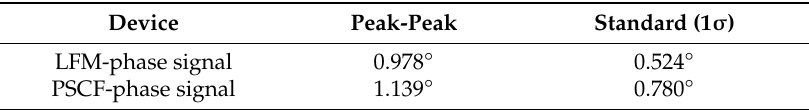
Table 2. The comparison results of two phase synchronization schemes.